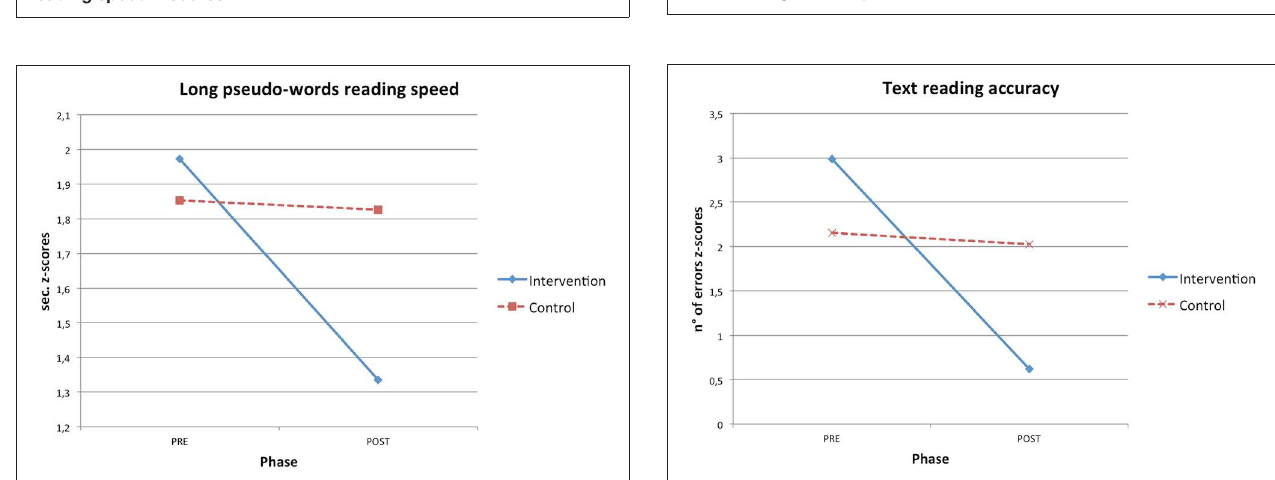
FIGURE 1 | Phase X condition interaction effect for short pseudo-word reading speed z-scores.